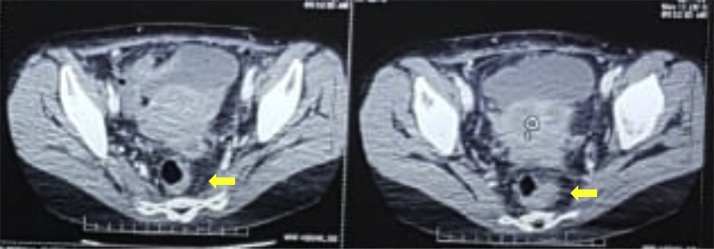
Preoperative MSCT scan with contrast shows large (7 cm) mass in descending colon tumor (yellow arrow).